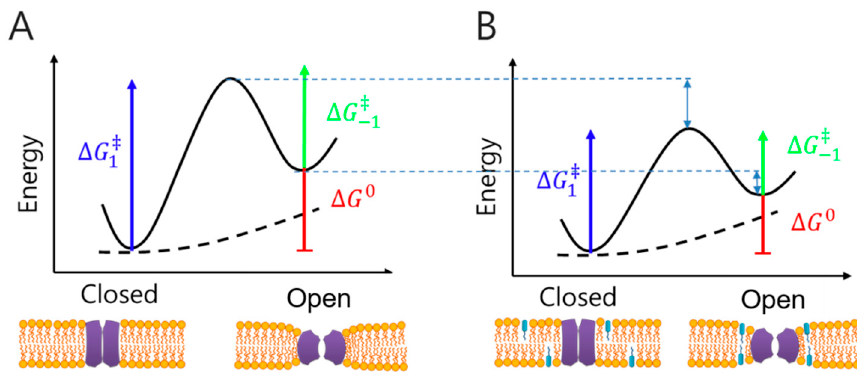
Figure 7. Free energy of membrane and membrane protein ( A ) without drug and ( B ) with drug. The drug alters the net free energy of the membrane by partitioning into the membrane.